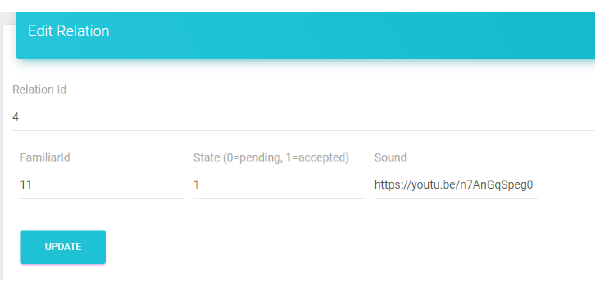
Figure 7. Managing the association of a Familiar with a characteristic